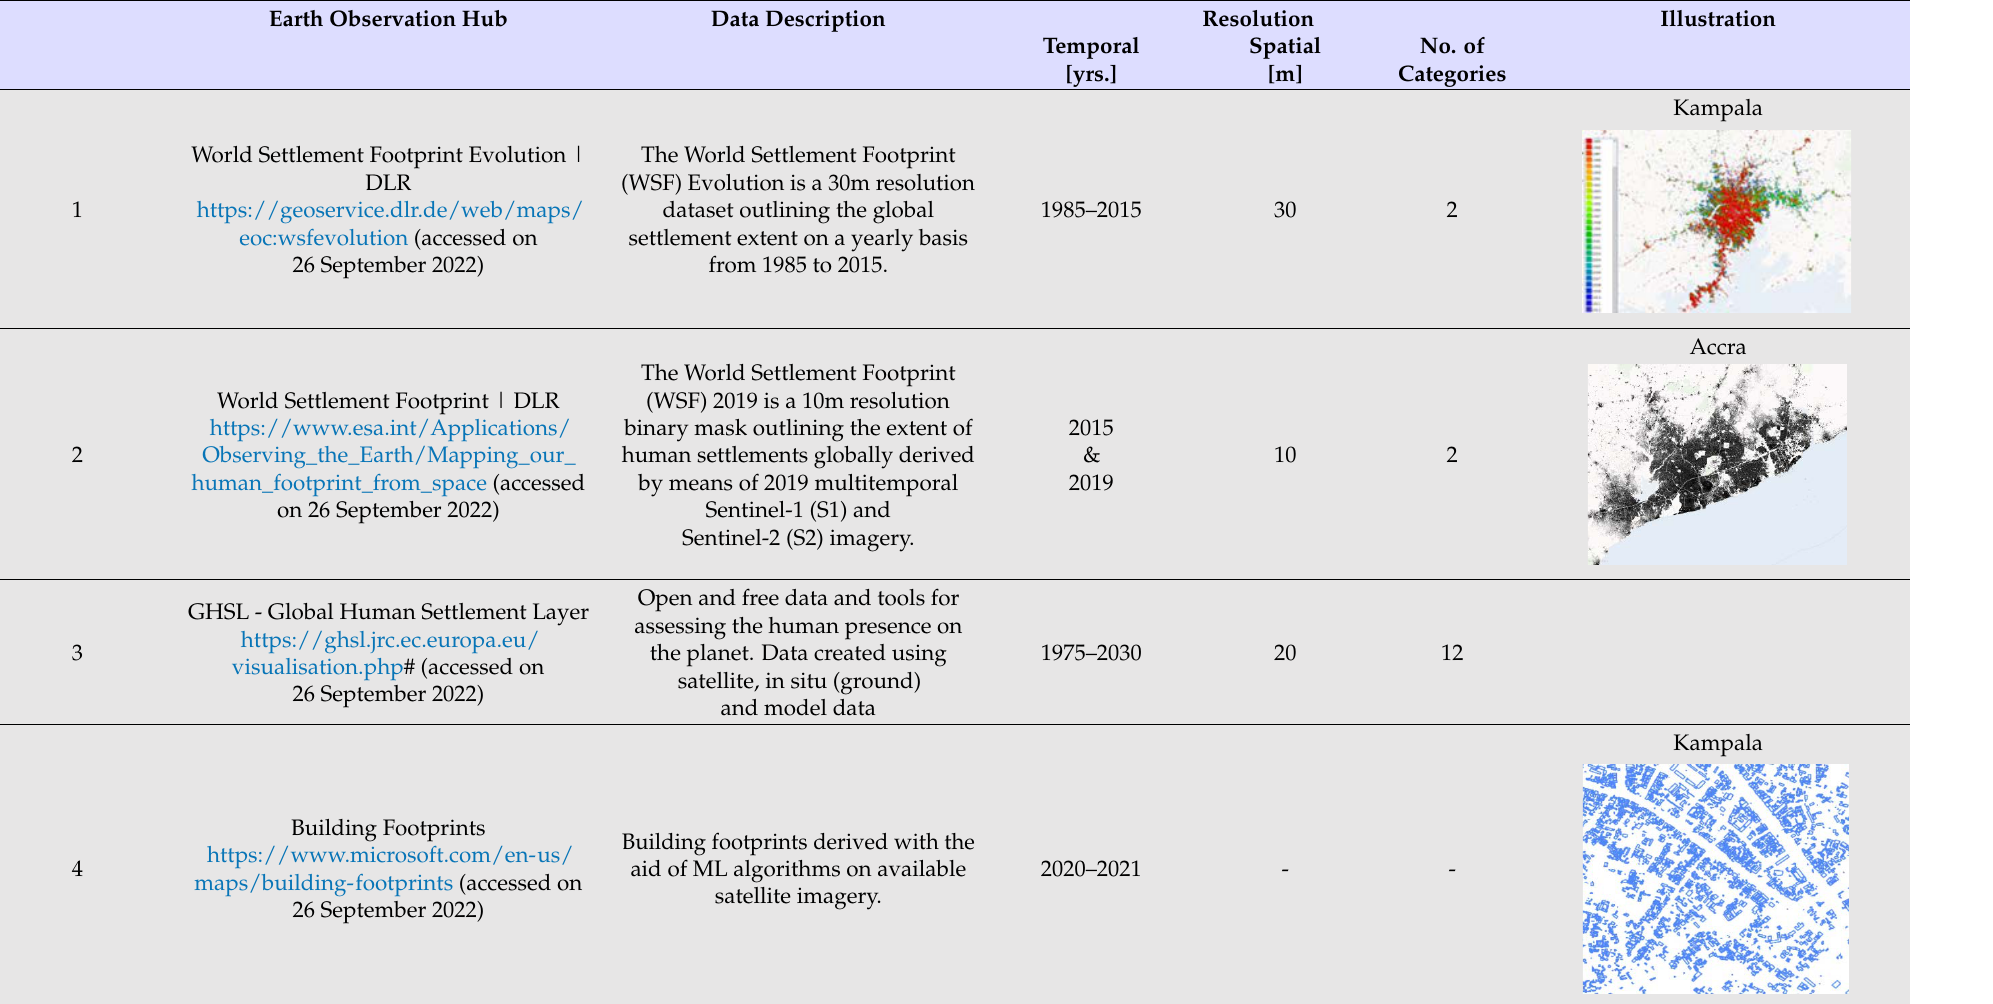
Table 2. Publicly available dataset revealing urban land use in different continents.